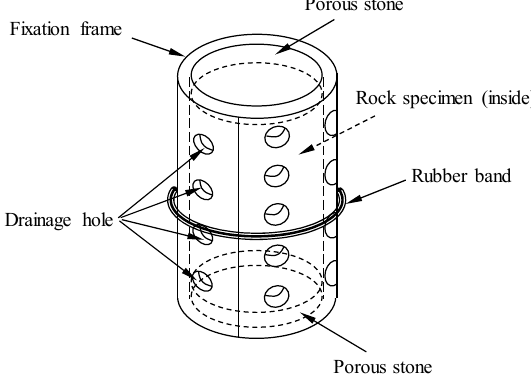
Figure 3. A protection device for mudstone specimen.